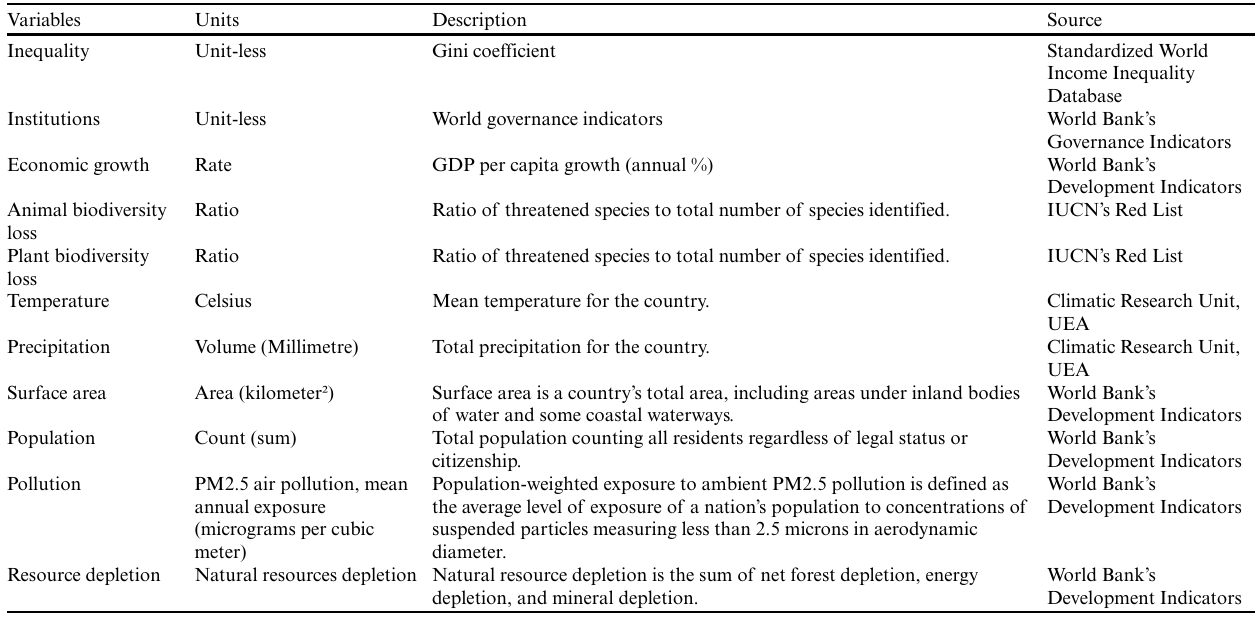
Table 1 . Data set description of